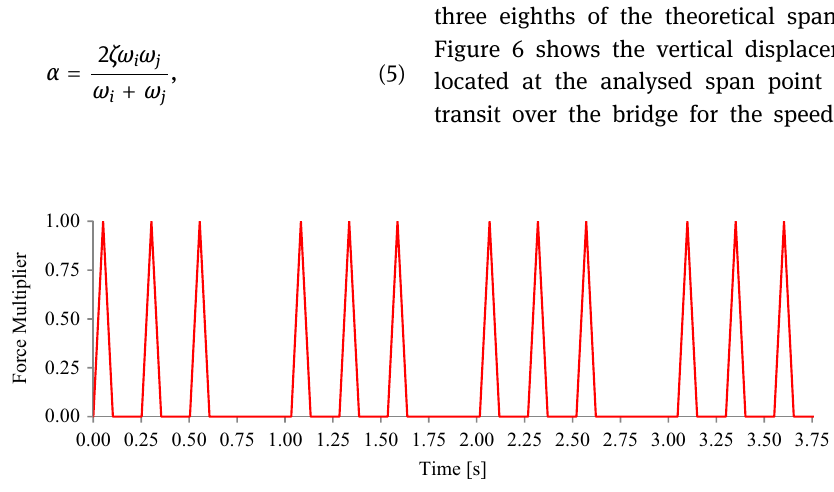
Figure 5: The load curve of a single bridge node for two locomotives travelling at the speed of 30